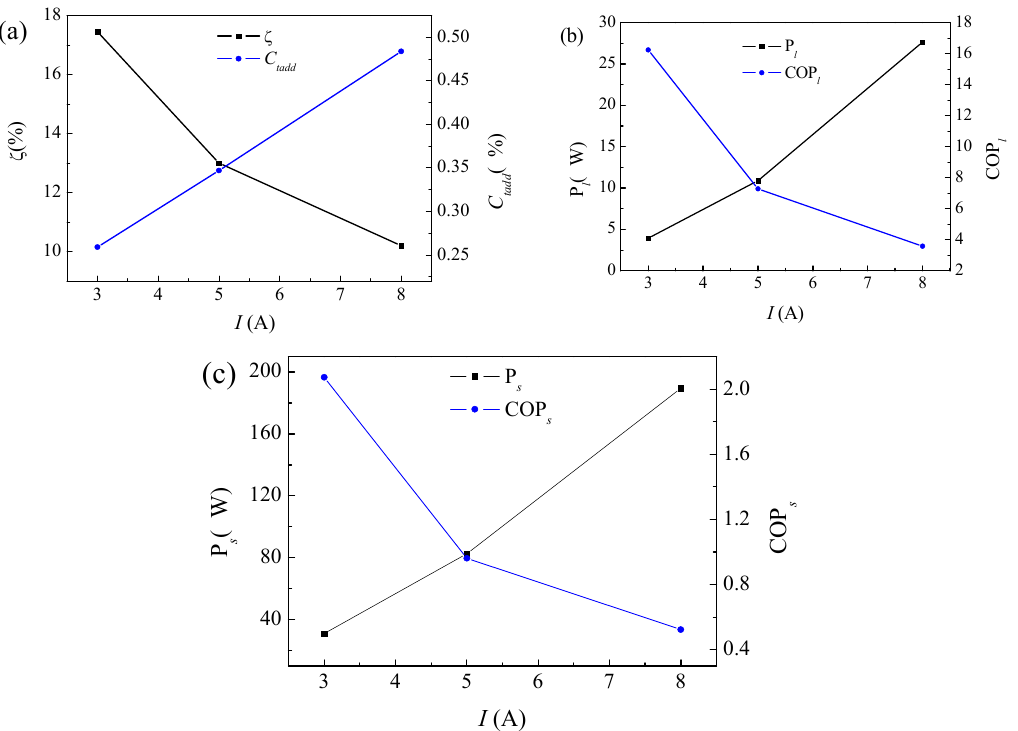
Figure 5. ( a ) The effect of current on the performance of the electrodialyzer; ( b ) the effect of current on the performance of the electrodialysis regeneration system under theoretical conditions; ( c ) the effect of current on the performance of the electrodialysis regeneration system under test conditions.